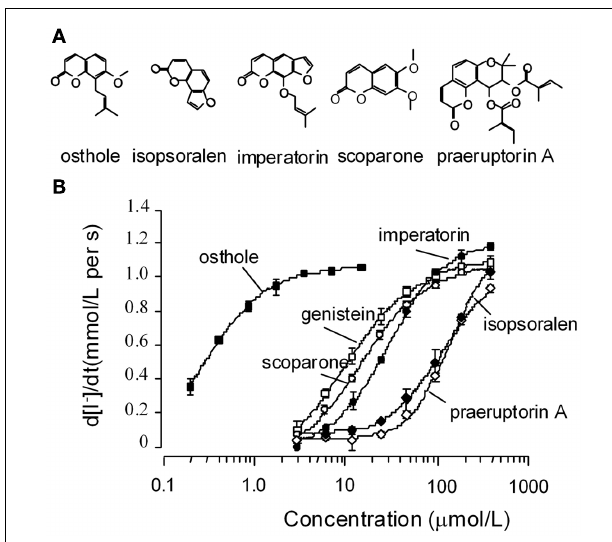
FIGURE 1 | Functional analysis of natural coumarin compounds in FRT cells expressing wild-type CFTR. (A) Chemical structures of the active coumarins. (B) Concentration–response curves for the active coumarins. Assays were performed in the presence of 0.1 μ mol/L forskolin. Genistein was used as a positive control. (mean ± SE, n = 4).